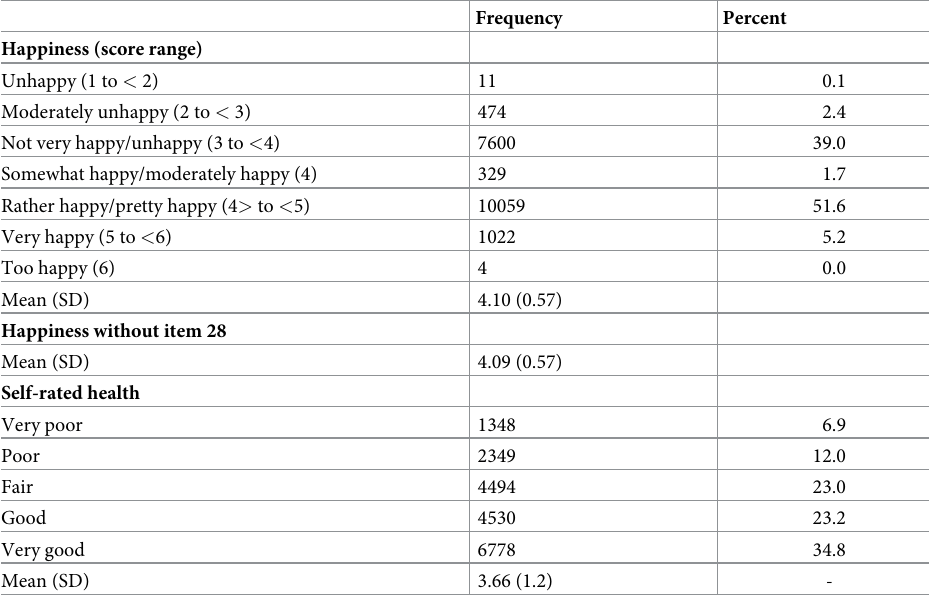
Table 2. Overall distribution of Oxford happiness scores and self-rated health scores (n =